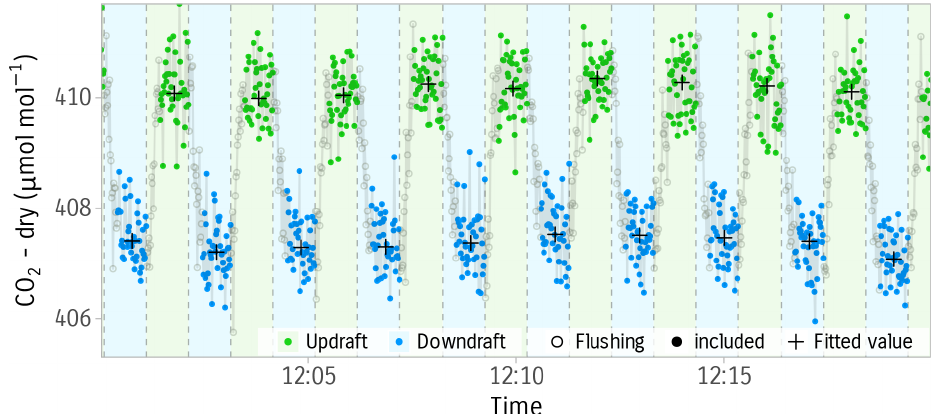
Figure 5. Data choice and fitting procedure for the STEA method. Points represent consecutive concentration measurements from the gas analyzer. Updraft and downdraft samples are highlighted in blue and green, respectively. Gray hollow points are excluded from the data fitting (flushing time). Crosses show the chosen representative concentrations for each short interval (the median). Further quality checks for raw data are outlined in Sect. 3.5.2. Data are from 21 June 2020 at